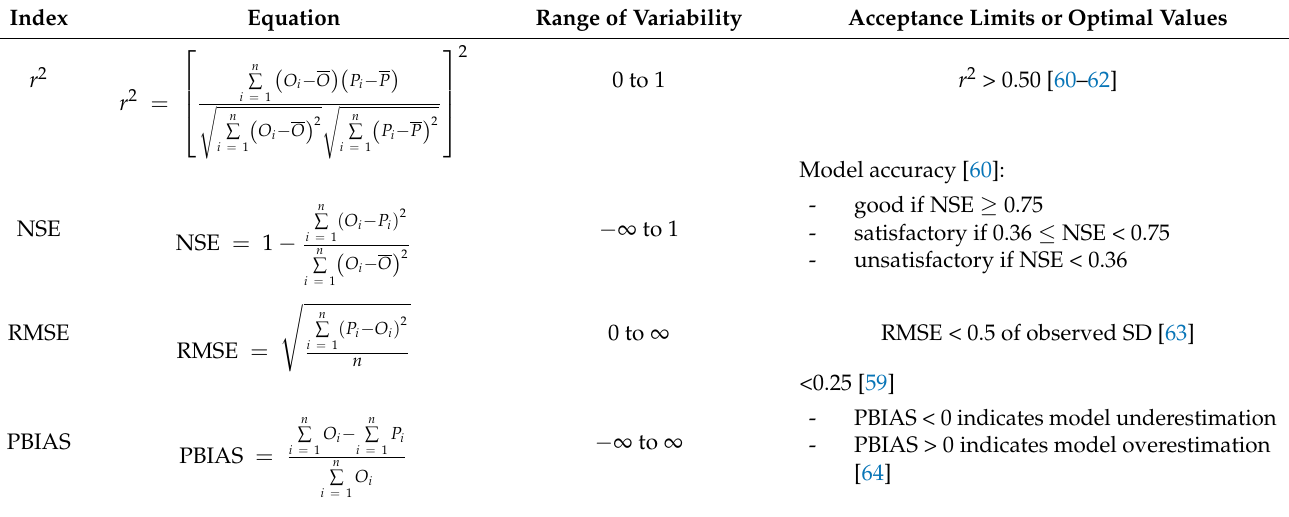
Table 3. Indexes, related equations, and range of variability to evaluate the prediction capacity of the regression